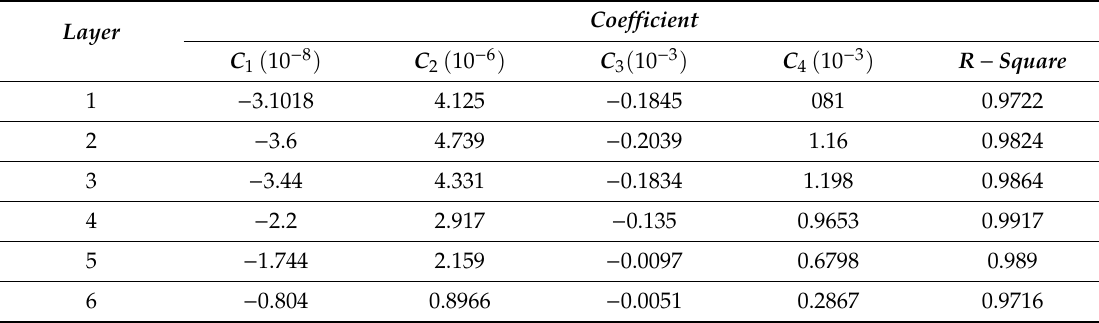
Table 3. The constant of thermal expansion interpolation function for each printing